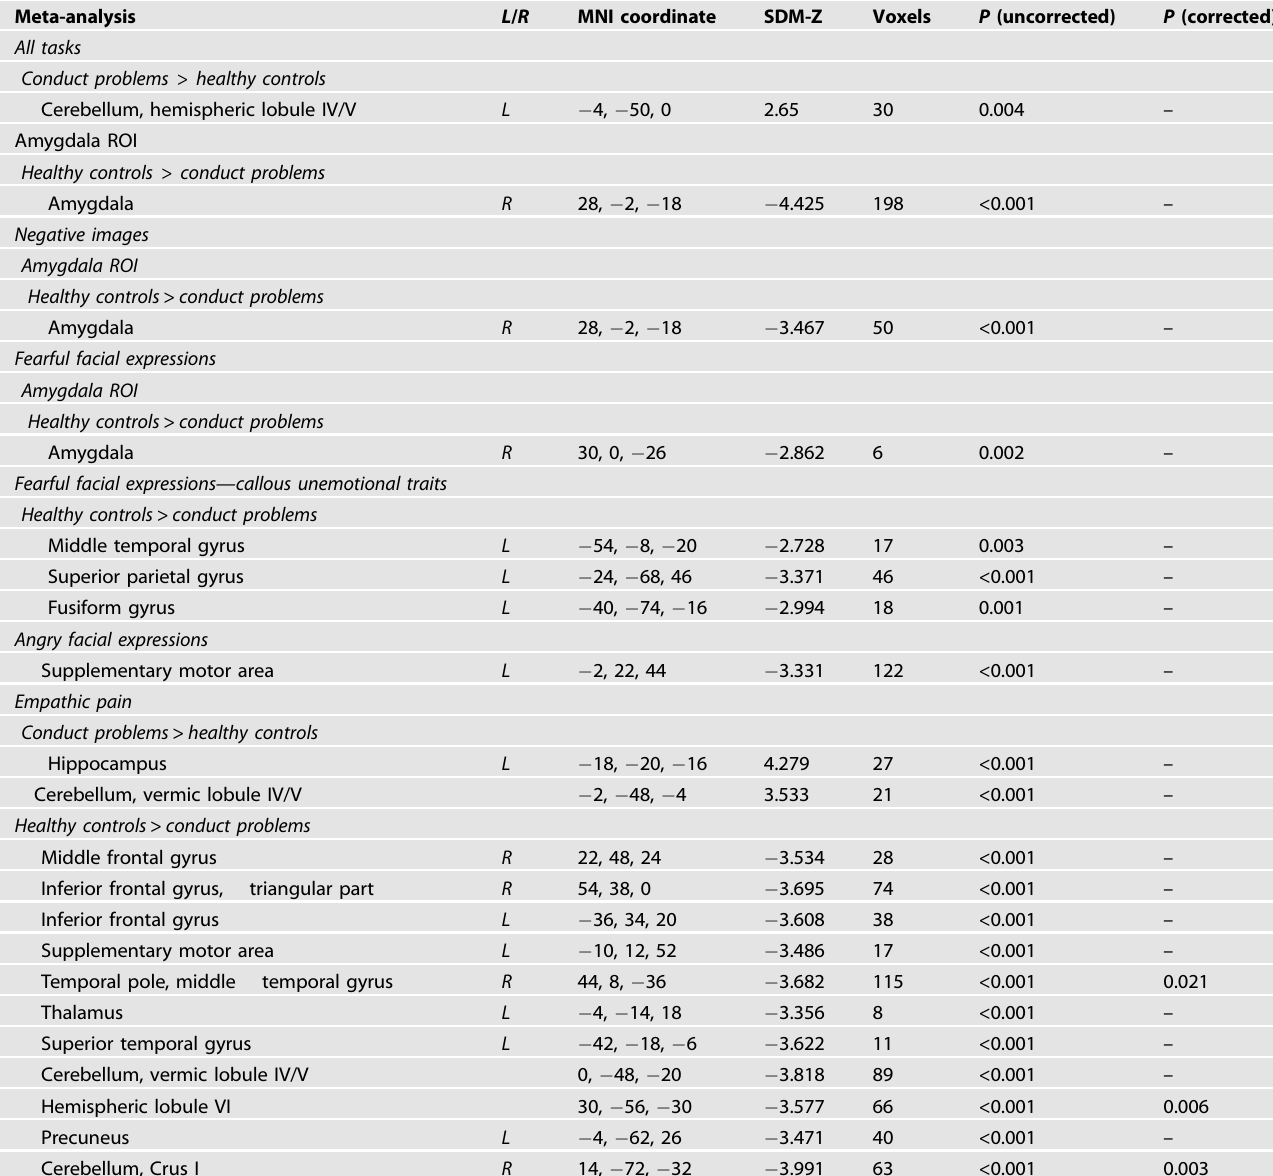
Table 2. Results of whole-brain and ROI fMRI meta-analyses of youths with conduct problems relative to healthy control youths by task domain and presence of callous-unemotional